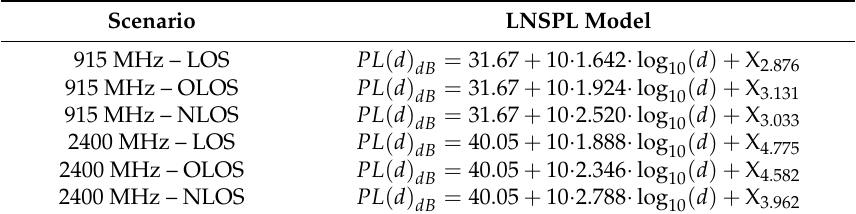
Table 1. Obtained propagation model's parameters for both frequency bands and different visibility